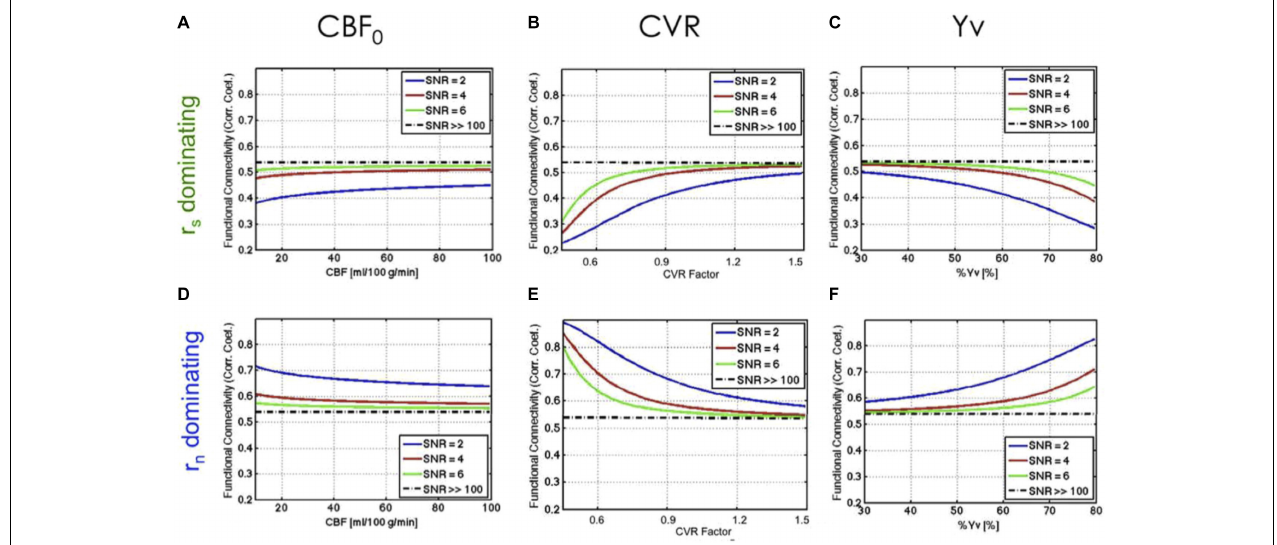
FIGURE 2 | Theoretical relationship between rs-fMRI functional connectivity and physiological variables. The dependence of function connectivity (FC) on all three physiological variables (CBF 0 , CVR, and Yv) is driven by the signal-to-noise ratio (SNR) and by the balance between signal-driven (r s ) (A–C) and noise-driven correlations (r n ) (D–F) . A lower SNR leads to more emphasized dependence of FC on baseline physiology. Figure reproduced from Chu et al. (2018) with permission from